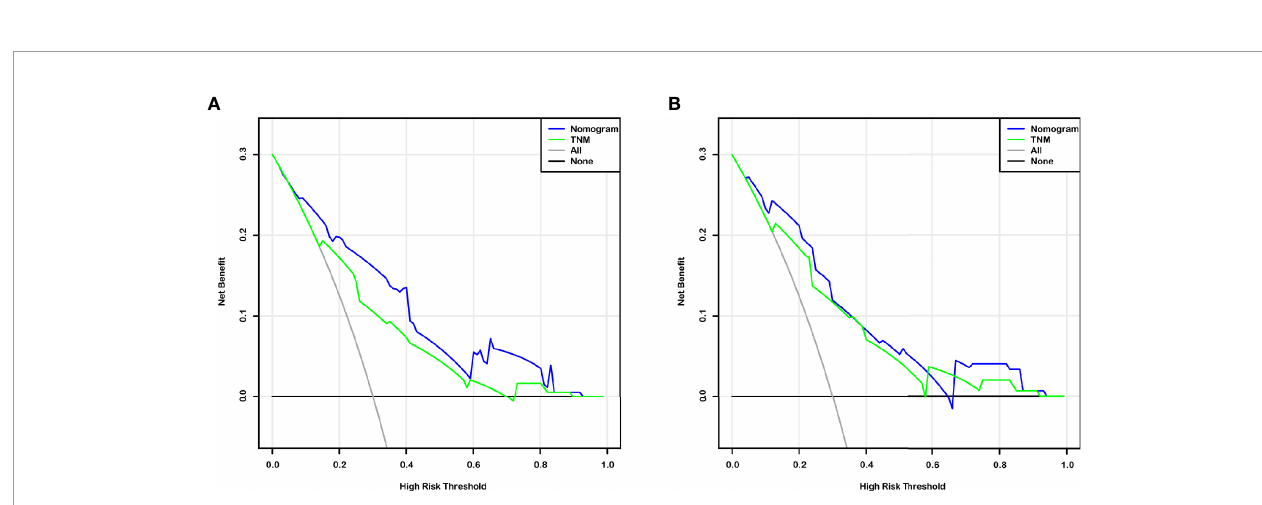
FIGURE 6 | Decision curve analysis (DCA) based on nomogram and TNM-stage for OS and DFS prediction of BCa patients after RC (A, B)